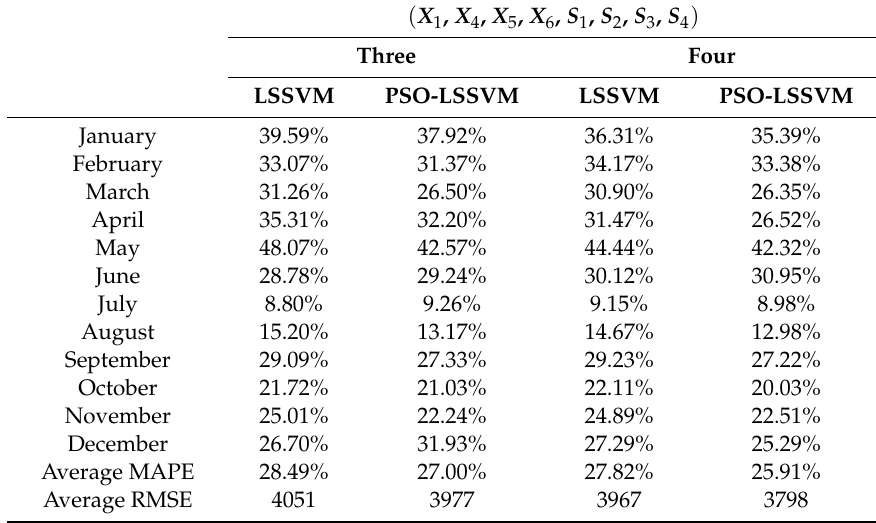
Table 7. Results of the predictions by PSO-LSSVM and LSSVM using three and four seasonal classes.